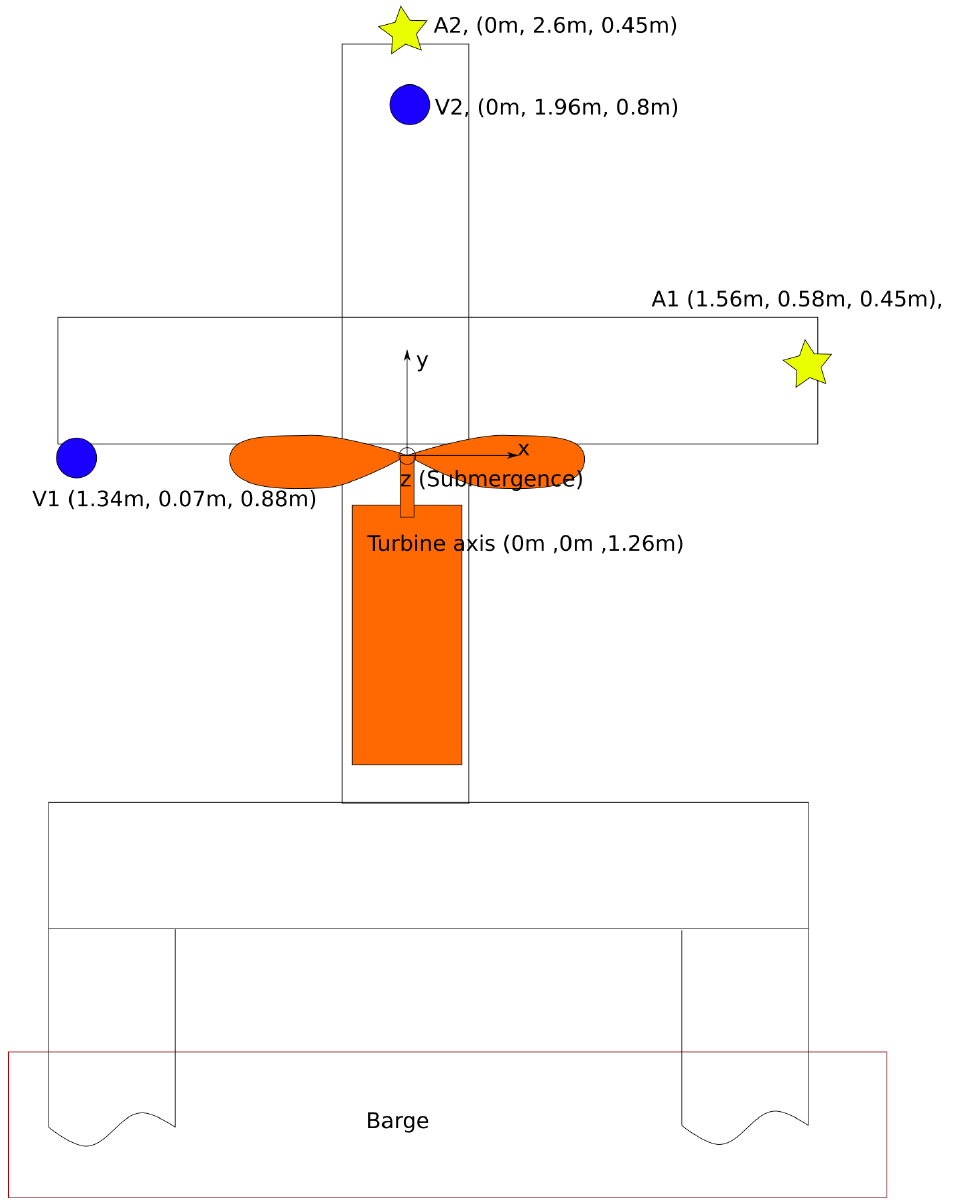
Figure 1. Instrument layout schematic (not to scale). Blue circles show Vector (V) locations, Yellow stars Acoustic Doppler Profilers (A). Distances of the sensor heads from the turbine axis are given in